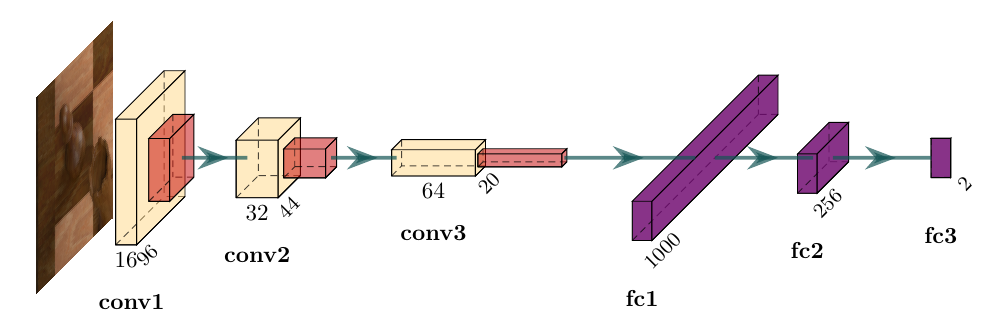
Figure 7. Architecture of the CNN ( 100,3,3,3 ) network for occupancy classification. The input is a three-channel RGB image with 100 × 100 pixels. The first two convolutional layers (yellow) have a kernel size of 5 × 5 and stride 1 and the final convolutional layer has a kernel size of 3 × 3. Starting with 16 filters in the first convolutional layer, the number of channels is doubled in each subsequent layer. Each convolutional layer uses the ReLU activation function and is followed by a max pooling layer with a 2 × 2 kernel and stride of 2. Finally, the output of the last pooling layer is reshaped to a 640,000-dimensional vector that passes through two fully connected ReLU-activated layers before reaching the final fully connected layer with softmax